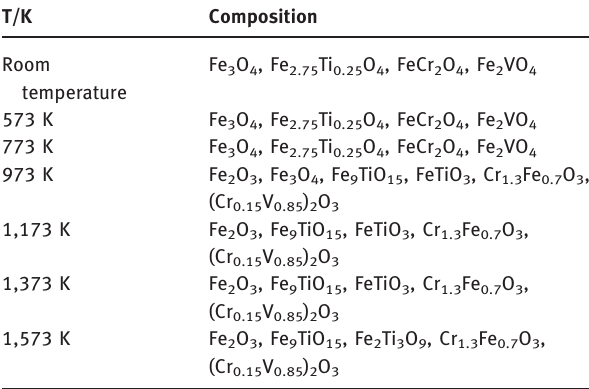
Figure 6: XRD patterns of HCVTM pellet roasted at different temperatures. Table 2: Phase compositions of HCVTM oxidized pellet at different